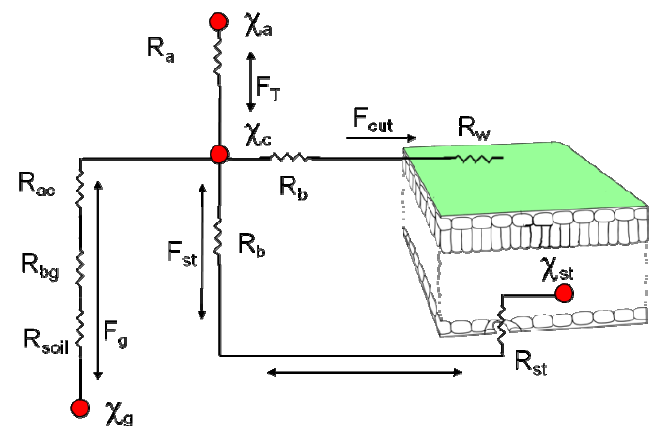
Figure 5. Schematic of bi-direction flux model for soil and